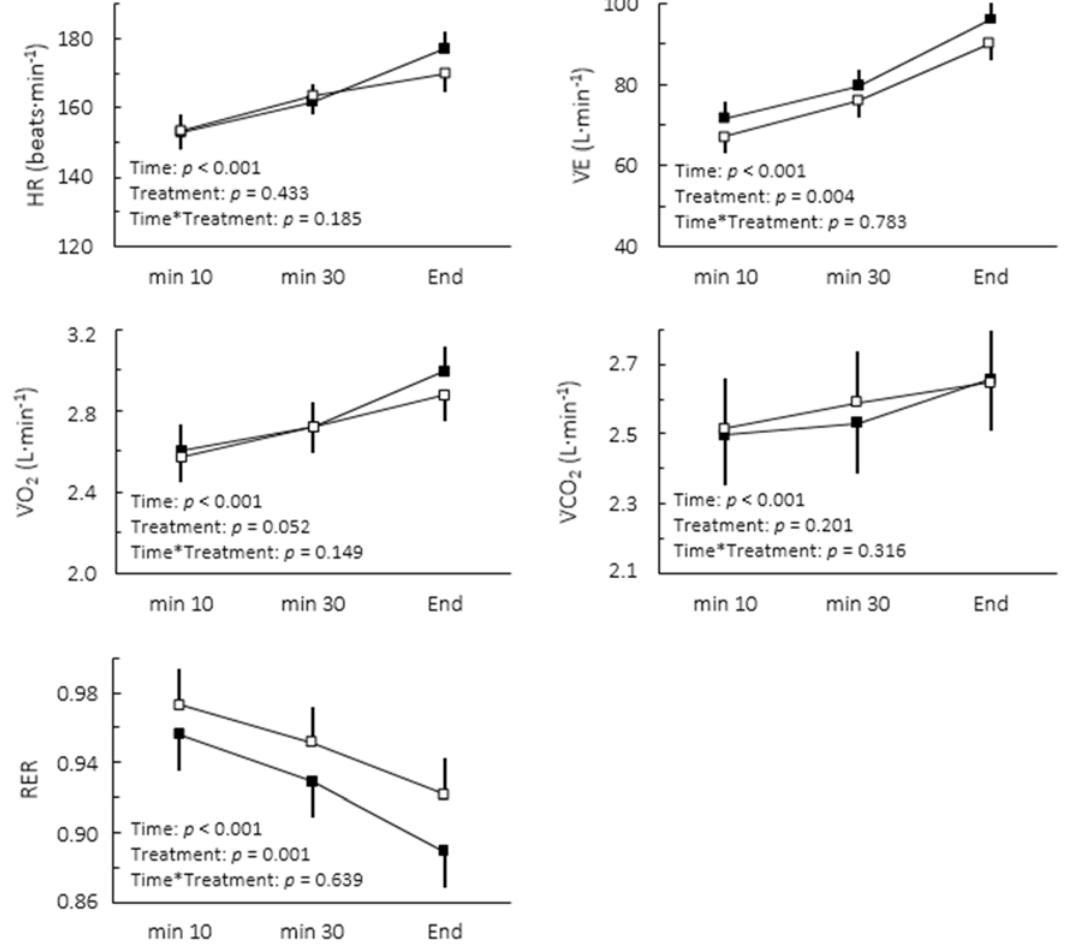
Figure 2. Cardiorespiratory responses to caffeine ( ▪ ) and placebo ( ▫ ) during cycling to exhaustion at maximal lactate steady state. Values are mean ± SE.